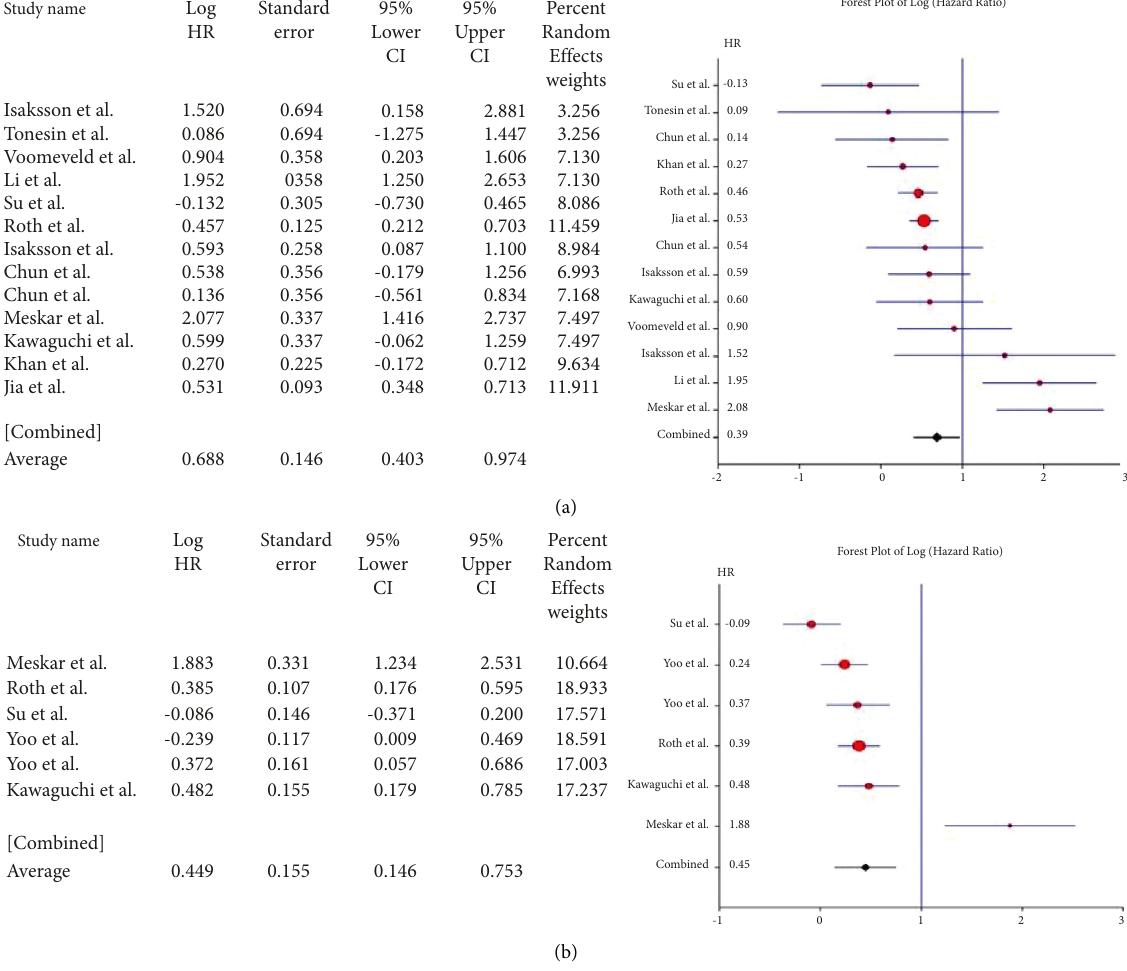
Figure 4: Forest plot of SMAD3/4 gene and overall survival in CRC (a). Forest plot of SMAD3/4 gene and disease-free survival in CRC